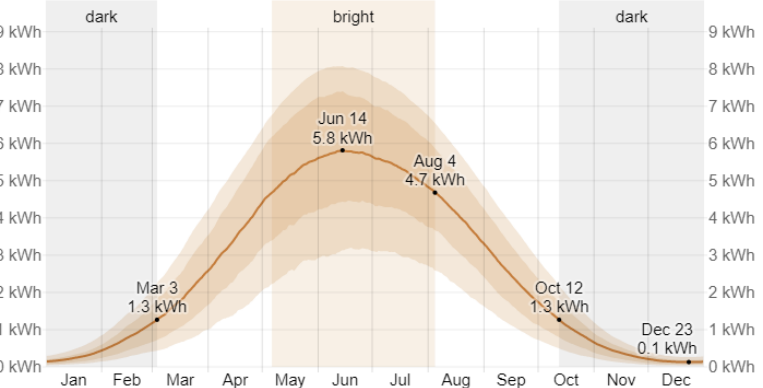
Figure 5. Average daily incident shortwave solar energy in Bergen, Norway [34].